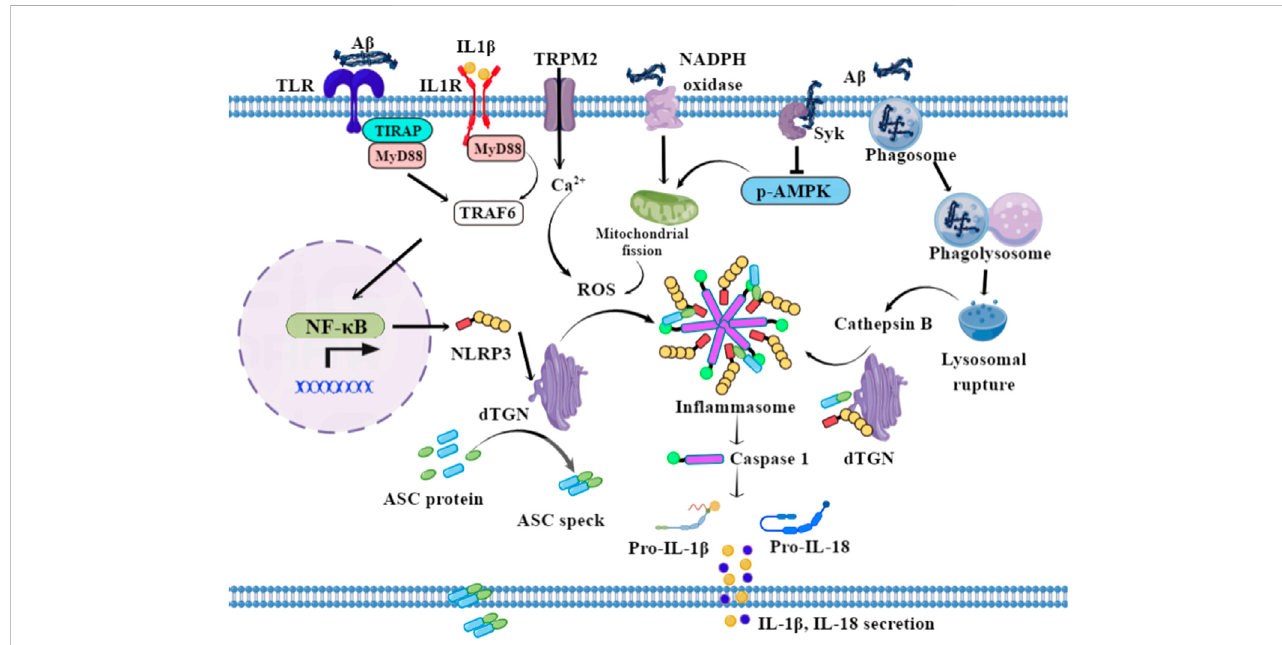
FIGURE 1 Possible mechanisms of NLRP3 activation in microglia. In the initiation signal, A β fi brils bind to TLR, and drive the transcription of NLRP3, pro-IL-1 β , and pro-IL-18 via NF- κ B signaling. In the activating signal, the lysosomal-rupture pathway and ROS generation pathway are the two classical routes for NLRP3- mediatedcaspase-1activation.ThephagocytosisofaggregatedA β bymicrogliatriggerslysosomalruptureandthesubsequentreleaseofcathepsinBintothe cytosol.Inaddition,A β triggersCa2 + in fl ux via TRPM2andactivatesNADPHoxidaseandSyk,subsequentlyinducingmitochondrialfragmentationandthe generation of ROS. Therefore, the stimuli — including ROS and cathepsin B — drive the dispersed transGolgi network (dTGN) to recruit NLRP3 through ionic bonding, leading to adaptor protein ASC polymerization and downstream signaling